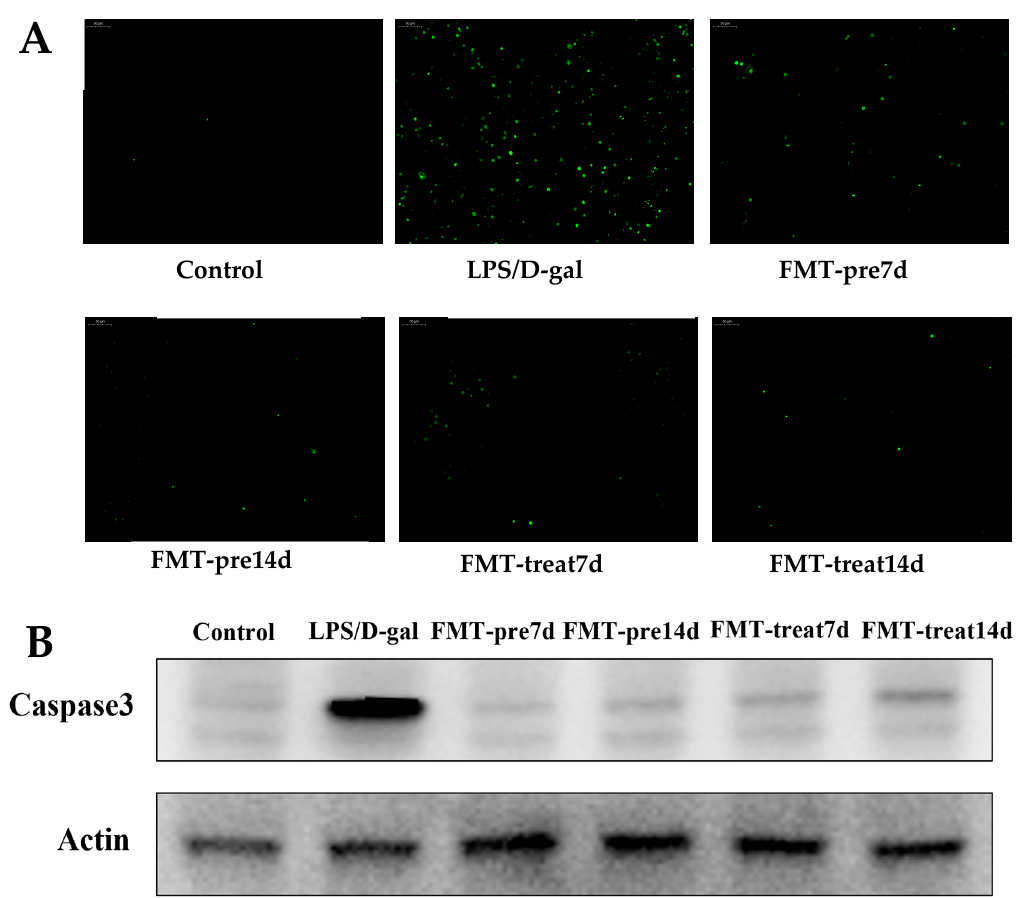
Figure 3. FMT suppressed apoptosis of hepatocytes in LPS/D-gal-induced mice. ( A ) Representative images of hepatic TUNEL staining. Green staining represented apoptotic cells (magnification ×20). ( B ) The expression of Caspase-3 was detected by WB.